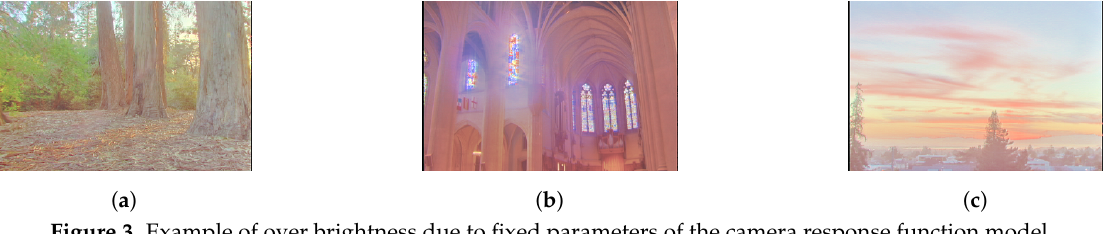
Figure 3. Example of over brightness due to fixed parameters of the camera response function